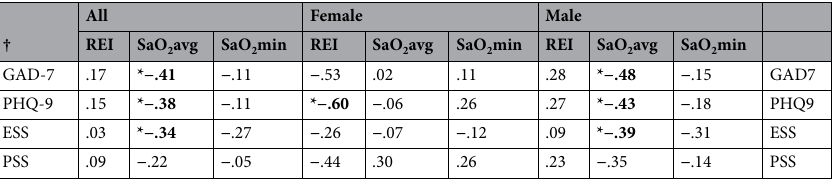
Table 3. Correlation of sleep study parameters with symptoms in OSA. OSA group Pearson’s correlation values are shown for OSA and control groups separately for combined-sex (All), female and male. * = significant correlation ( P ≤ 0.05) Not all control participants had a sleep study so these correlations were not calculated for those groups. † ESS Epworth Sleepiness Scale, GAD-7 Generalized Anxiety Disorder scale,